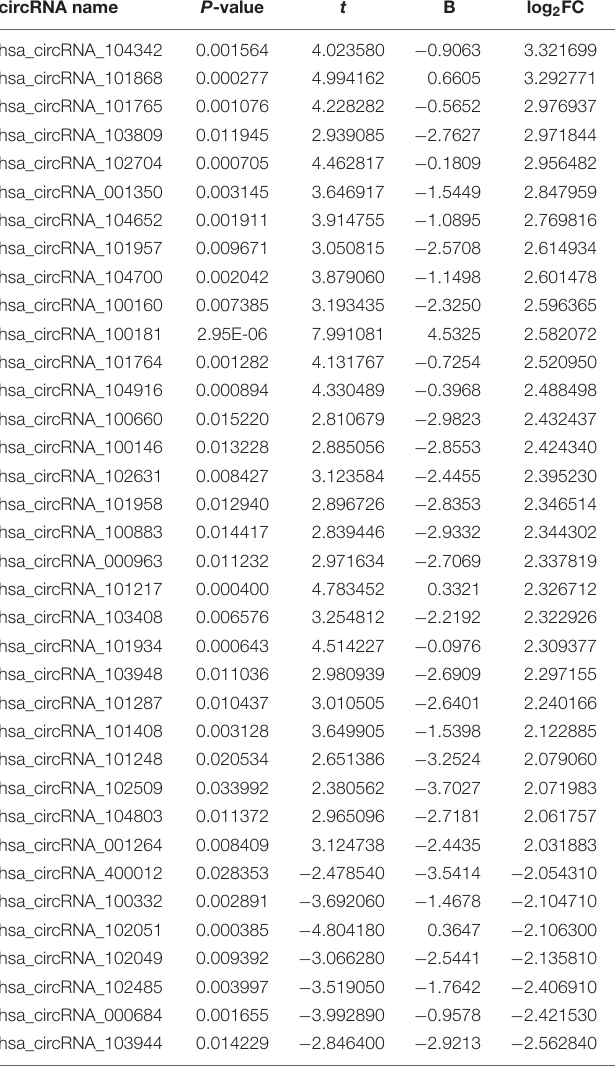
TABLE 2 | The differentially expressed circRNAs (DECs) with significance (|log 2 FC| > 2 and P < 0.05) between papillary thyroid carcinoma (PTC) and normal thyroid